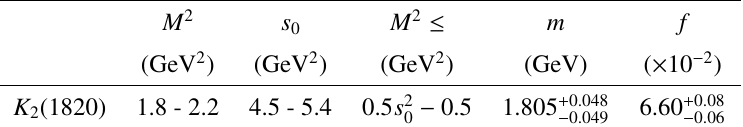
Table 1: For K 2 (1820), working ranges of M 2 and s 0 (columns 2-4), and vacuum values of the mass (column 5) and the decay constant (column